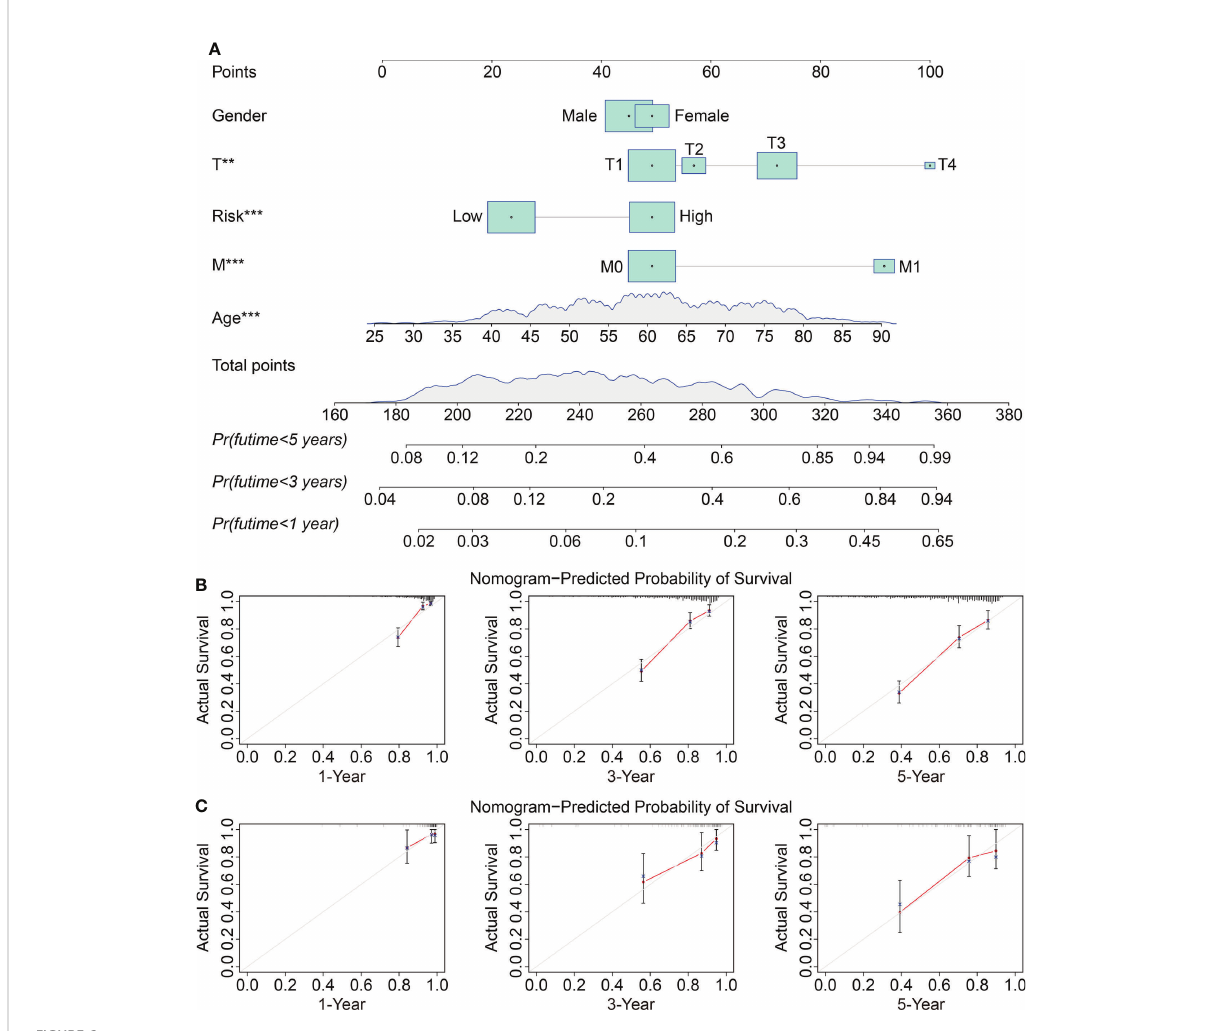
FIGURE 6 Construction and validation of a prognostic nomogram in ccRCC. (A) The nomogram combining risk score with clinical factors such as gender, age, T and M status for forecasting 1-, 3-, and 5-year overall survival. (B, C) The calibration plots of predicted and actual probabilities for the nomogram in TCGA and ICGC cohorts ** P < 0.01; *** P <